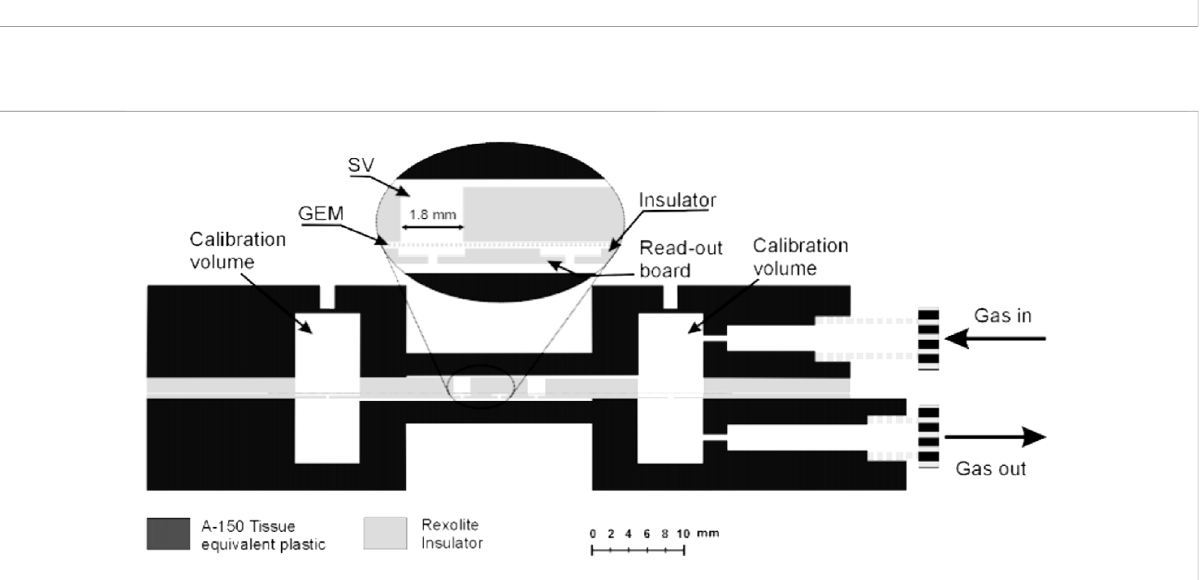
FIGURE 4 Schematic cross-sectional view of a GEM-based TEPC prototype. Only two out of the fi ve sensitive volumes can be seen. Source: